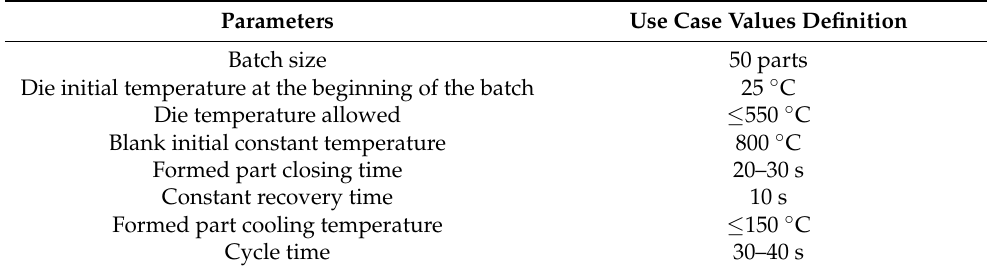
Table 1. Parameter range setting in the hot stamping process case